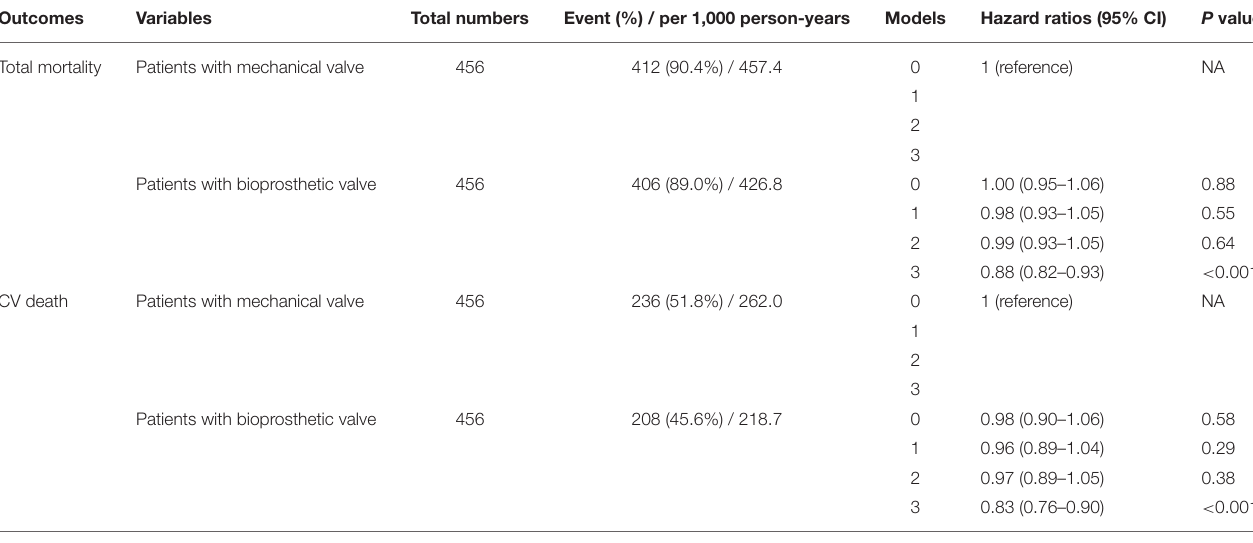
TABLE 2 | Incidence rates and effect sizes of outcomes by valve replacement status in ESRD group. Outcomes